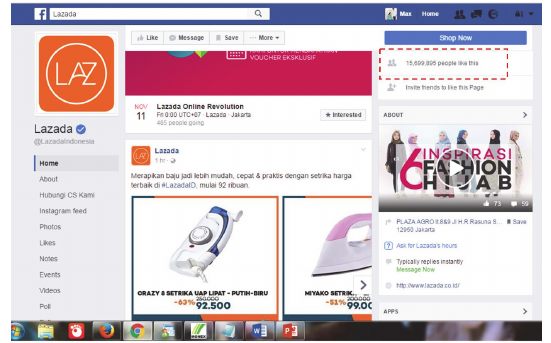
Fig. 2. Advertising of Lazada Indonesia in